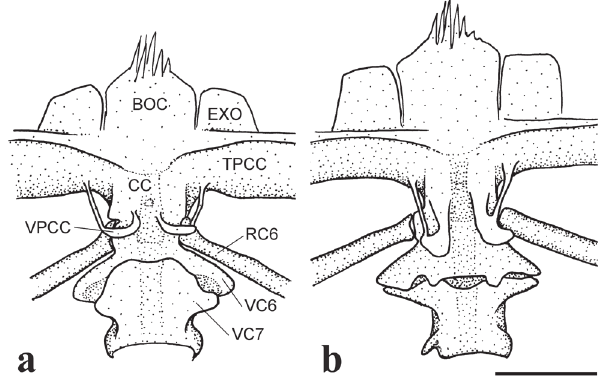
Fig. 6. Complex centrum of Pareiorhaphis . (a) P . cameroni , MCP 17276 and (b) P . scutula , MCP 37182. BOC - basioccipital, CC - complex centrum, EXO - exoccipital, RC6 - rib of the sixth vertebral centrum, TPCC - transverse process of the complex centrum, VC - vertebral centrum, VPCC - ventral process of the complex centrum. Ventral view. Scale bar = 2